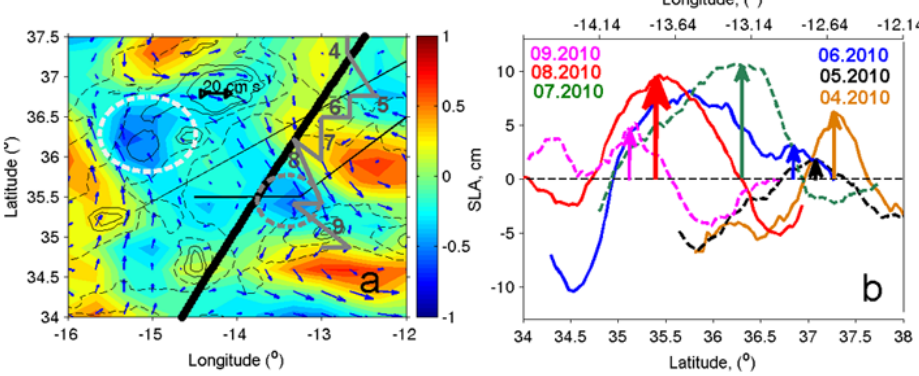
Fig. 4. (a) Relative vorticity (10 − 5 s − 1 ) and geostrophic currents (cms − 1 ) on 24 August 2010 computed from AVISO altimetry. Position of the meddy surface signal during this date is marked with a grey circle; position of the anticyclonic meander of the AzC is marked with a white circle. Pass 137 of Jason-1 (thick black line), the ADCP sections (thin black lines) and the meddy track (thick grey line) are overlaid. The numbers near the meddy track mark the beginnings of the respective months. Depth contours of 1000 and 1500m (solid lines), 3000 and 4000m (dashed lines) are shown. (b) Local sea-level anomalies (SLA, cm) of Jason-1 (pass 137) from April to September 2010, from the RADS data set (to increase clarity only every 3rd profile is presented in the figure). SLA for different months is presented with different colours. Arrows mark the centres of the tracked meddy signal, the thick arrow marks the centre of the meddy at the time of the cruise.